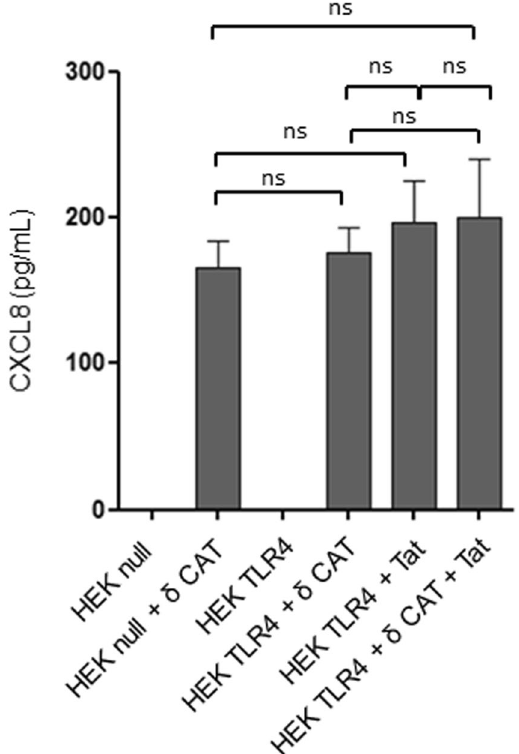
Figure 5. PKC- δ and Tat-TLR4 induces CXCL8 production through a common pathway. HEK cells or HEK TLR4 cells (10 6 /well) were either treated with HIV-1 Tat (10 nM), transfected with 0.5 µ g of PKC- δ CAT or both. After 24 hours of incubation cell supernatants were collected and CXCL8 production was quantified by ELISA. The data represent means and standard deviation (SD) of three independent experiments.